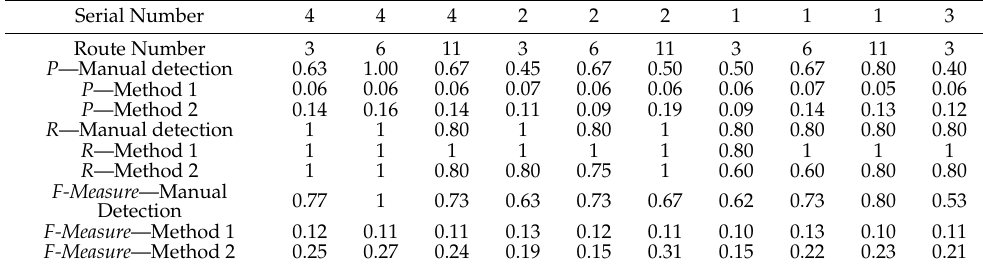
Table A3. Values of the obtained parameters P , R , and F − measure